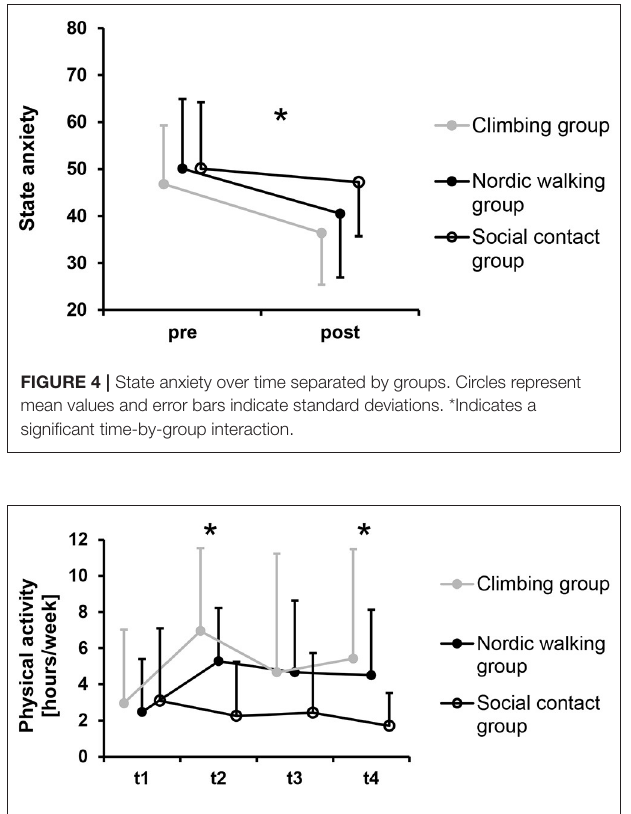
FIGURE 5 | Physical activity pre program (t1), post program (t2, n = 54), at follow-up 3 months post program (t3, n = 50), and at follow-up 6 months post program (t4, n = 49) separated by groups. Circles represent mean values and error bars indicate standard deviations. *Indicates a significant group difference in the analysis adjusted by physical activity pre